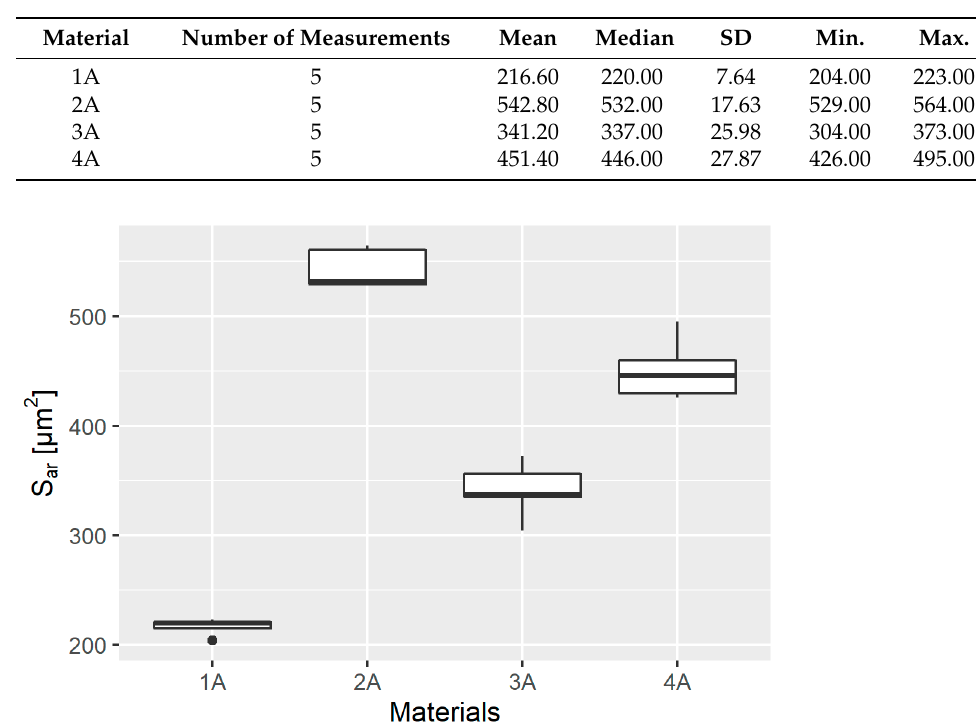
Table 9. Basic descriptive statistics of the results of measurement of the cross-sectional area of S ar scratches based on the measurements made using the optical profilometer in individual material groups.